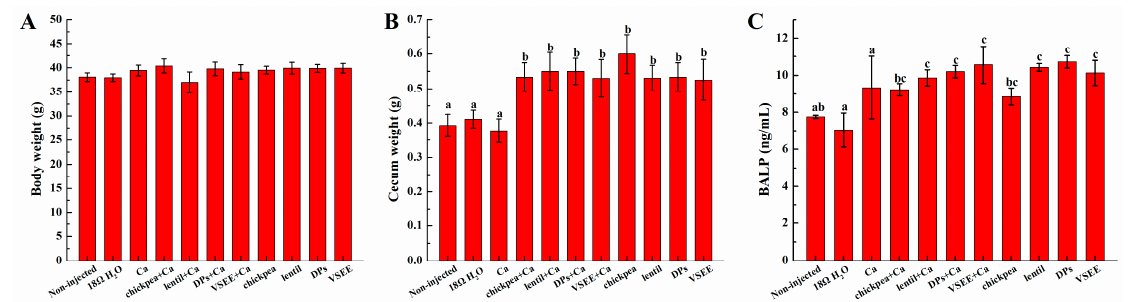
Figure 2. The effect of chickpea prebiotics, lentil prebiotics, Desalted duck egg white peptides (DPs) and Val-Ser-Glu-Glu (VSEE) on the: ( A ) body weight; ( B ) cecum weight; and ( C ) serum bone alkaline phosphate. Values are means ± SEM. a,b,c within a column, means without a common letter are significantly different, p < 0.05 (Duncan’s multiple range test at p < 0.05.